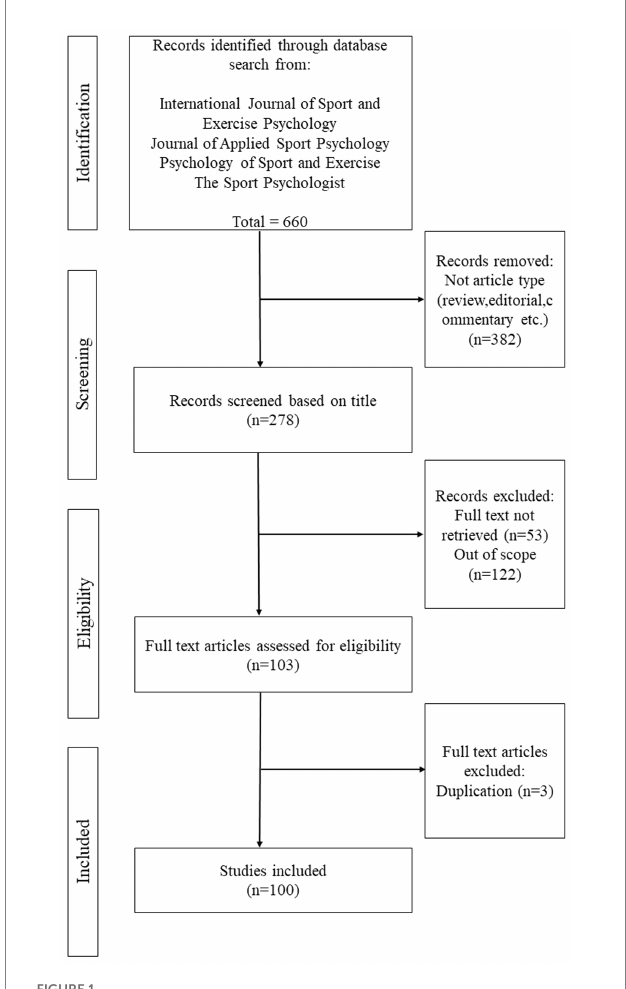
FIGURE 1 PRISMA procedure for assessing included studies related to coach